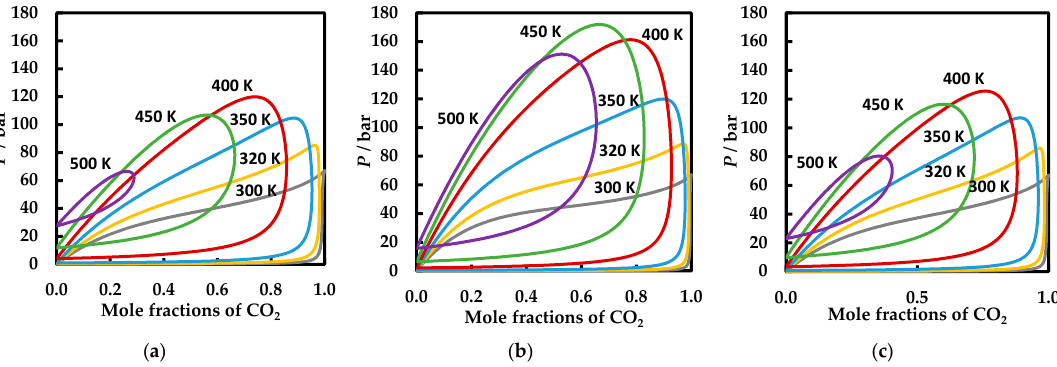
Figure 9. VLE behavior at six temperatures (300, 320, 350, 400, 450, and 500 K) for the carbon dioxide + ethyl acetate ( a ), carbon dioxide + 1,4-dioxane ( b ), and carbon dioxide + 1,2-dimethoxyethane ( c ) binary systems. The lines correspond to PR EoS predictions with the BIPs k 12 = 0.025 and l 12 = − 0.108.